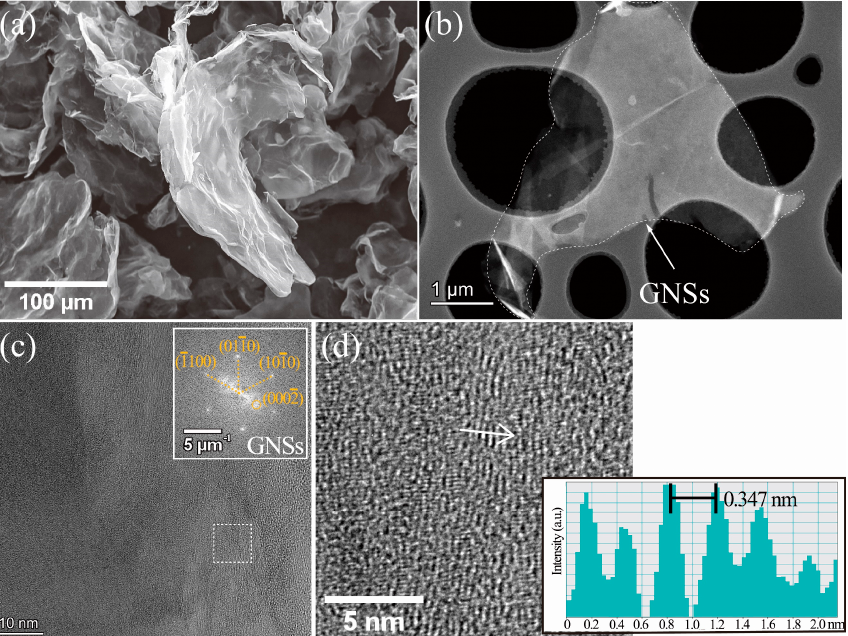
Figure 2. SEM image ( a ), HAADF-TEM image ( b ), HRTEM image ( c ), and magnified HRTEM with ( d ) lattice fringe of GNSs.